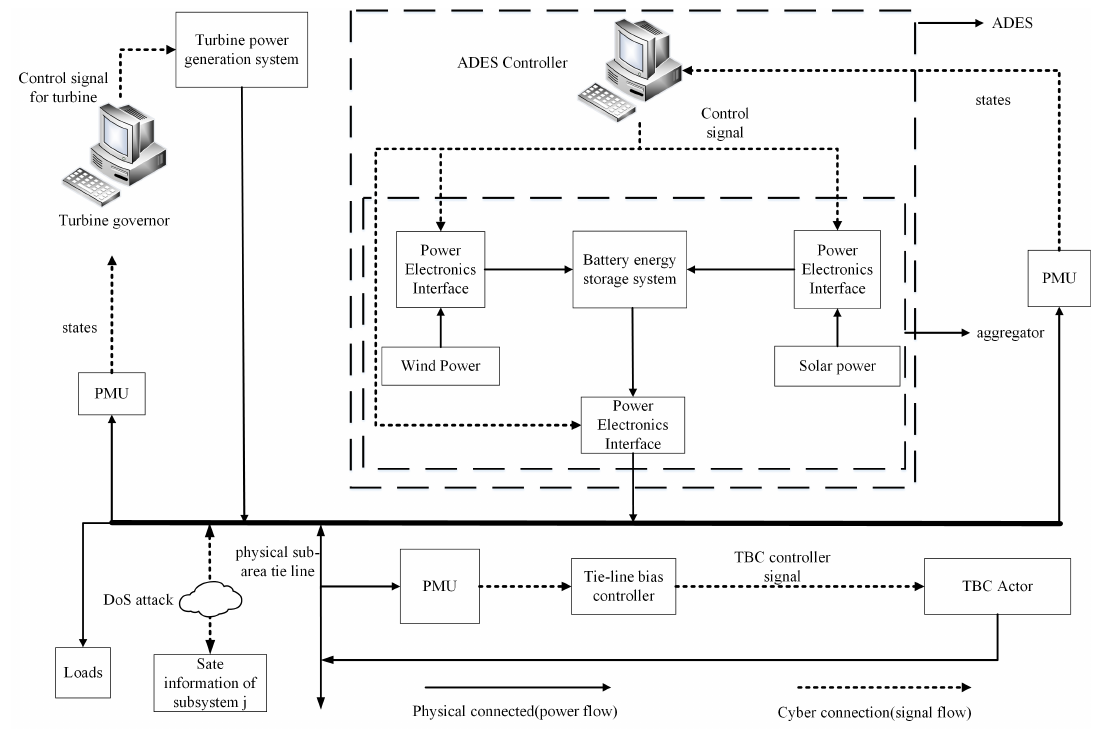
Figure 1. Subsystem structure